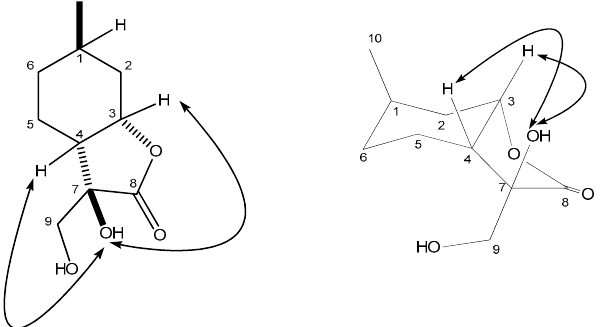
Figure 2. Determination of the structure of diol 18 by NOESY.